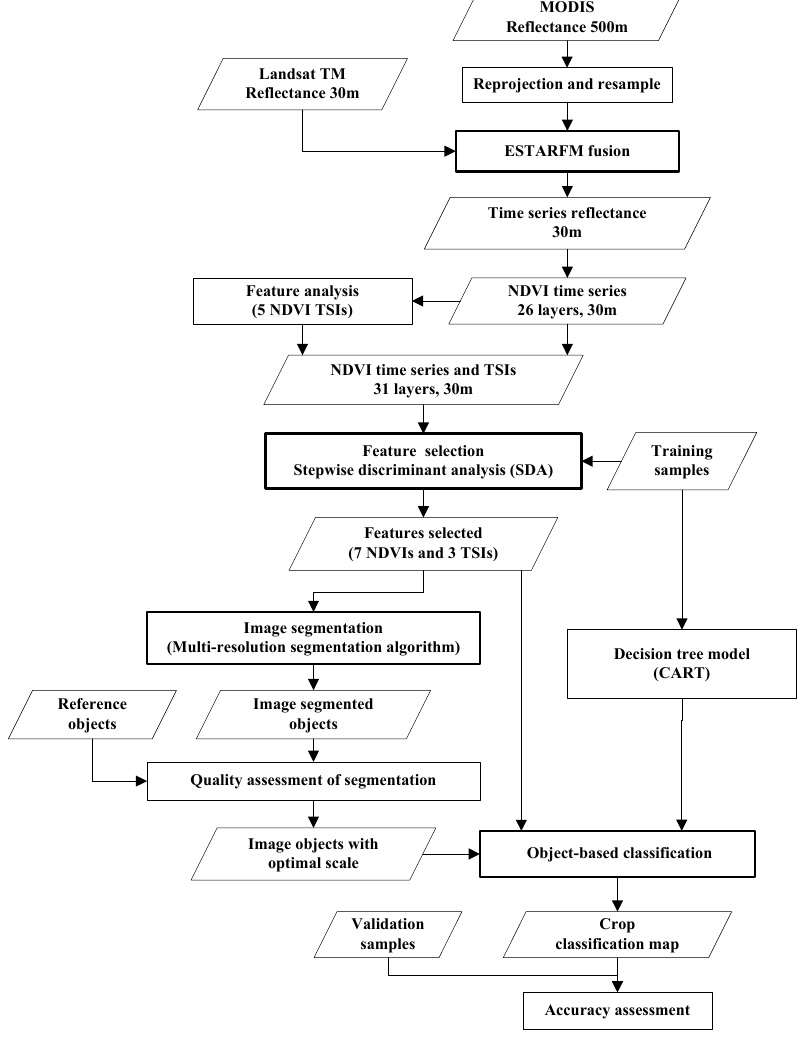
Figure 1. Flow diagram of crop classification.